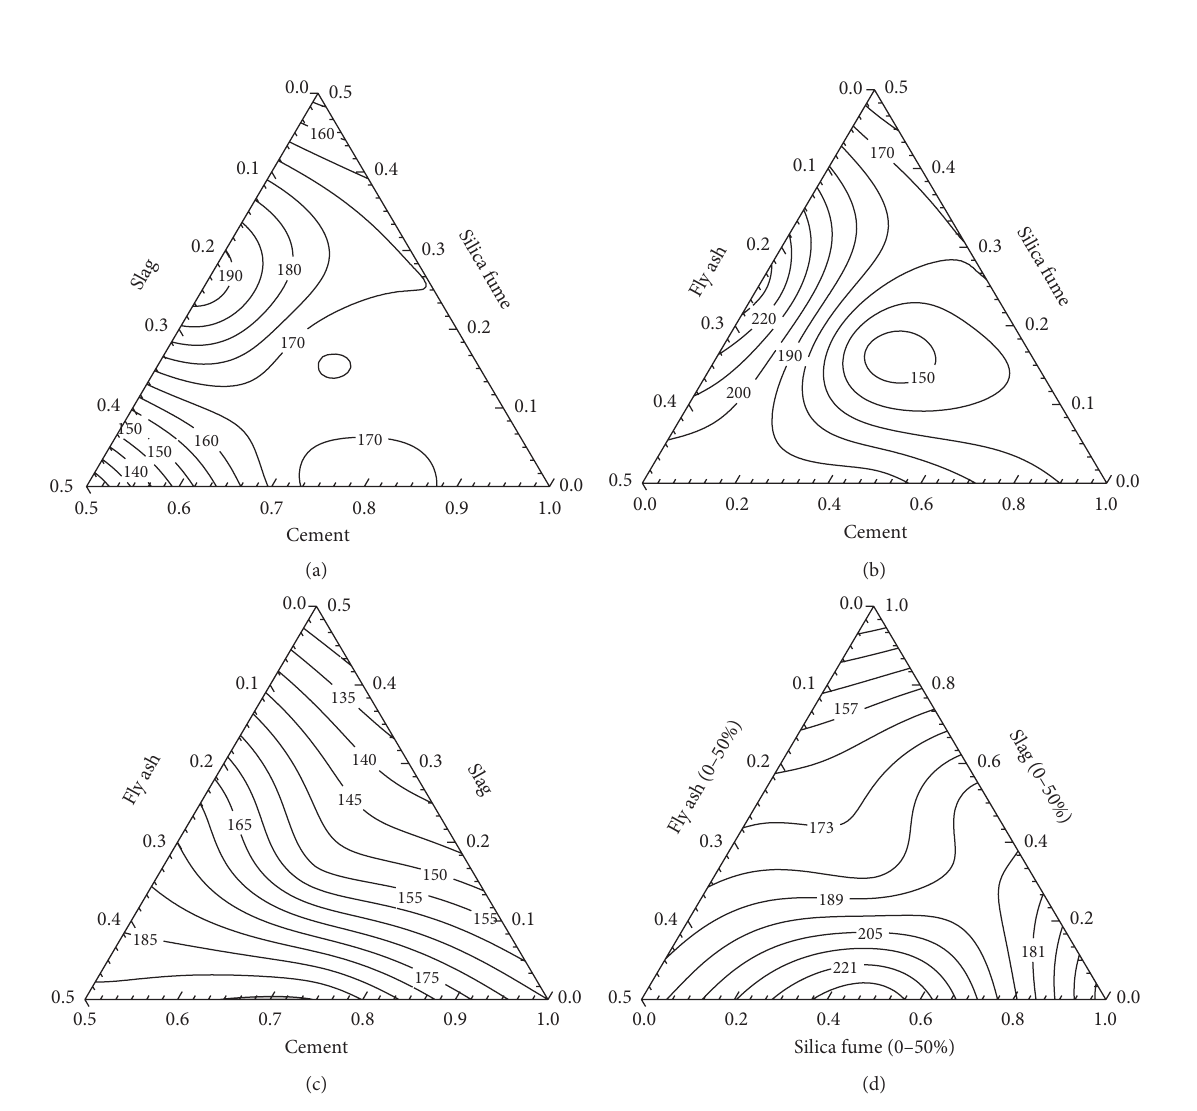
Figure 4: Flowability of UHPC with cement-silica fume-slag-fly ash binder